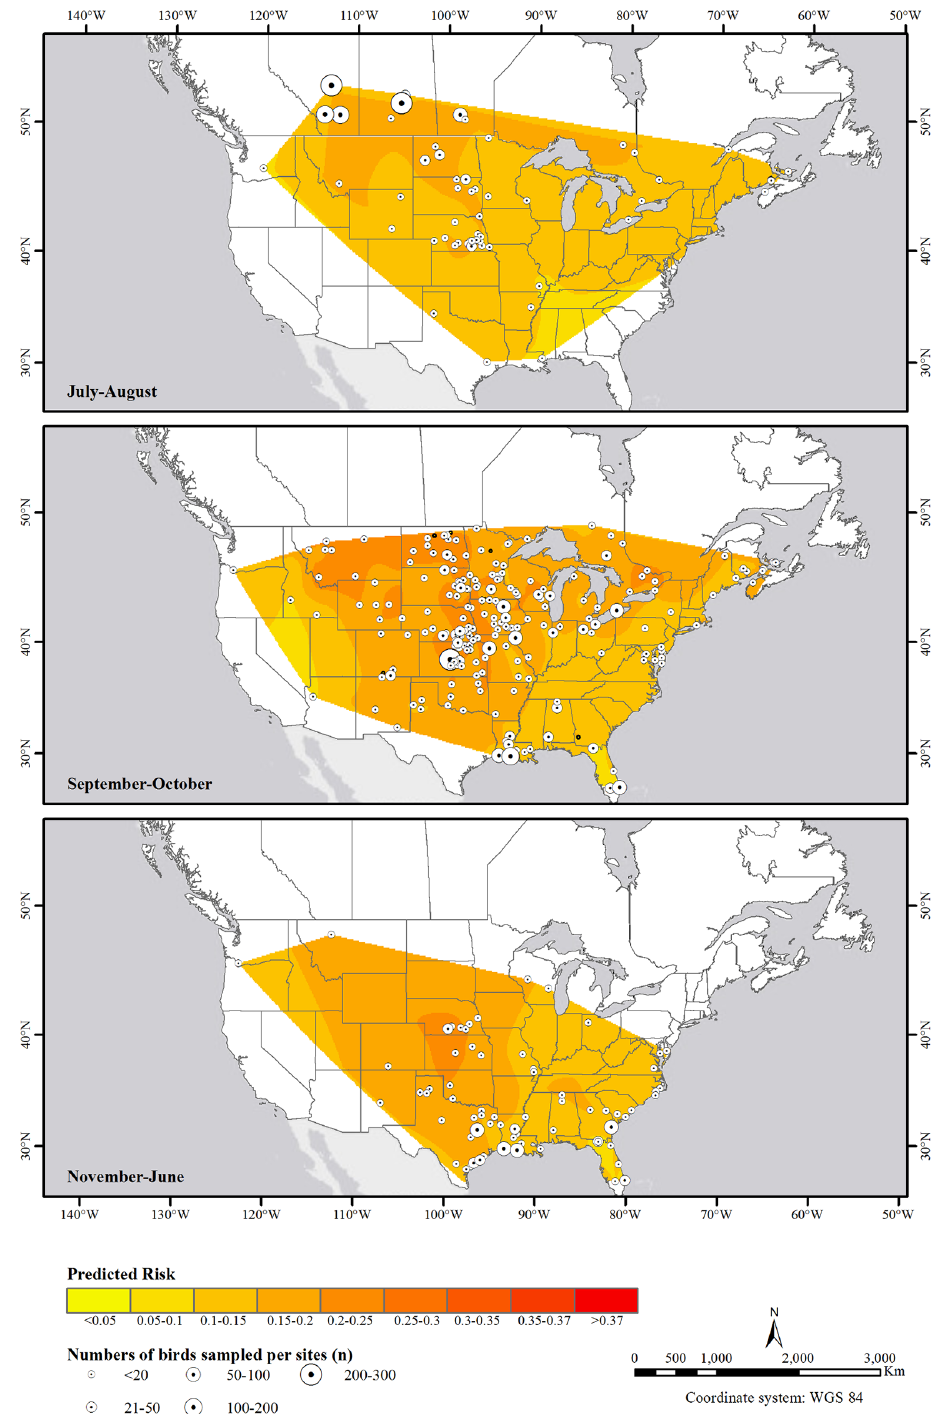
Fig 6. Predicted risk of avian influenza virus infection in after hatch year Blue-winged Teal in Canada and the US from 2007 – 2010 at different stages of the annual life cycle. Natural neighbor interpolation spatial analysis was applied to predicted probability values calculated for all after hatch year birds based on the best-supported model (Table 3), and averaged across all years and both sexes for each sampling site